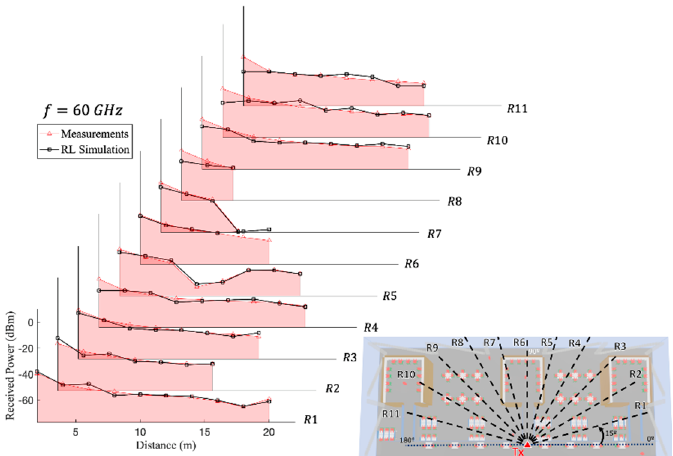
Figure 15. Experimental measurements and 3D-RL simulation comparison at 60 GHz frequency along the different linear radial distributions R 1 , …, R 11 depicted in Figure 8. Table 6. Differences between the measurements and simulation for the different linear distribution radials presented in Figures 14 and 15 and the measurements points of Figure 16. Difference Sim. vs. Meas.